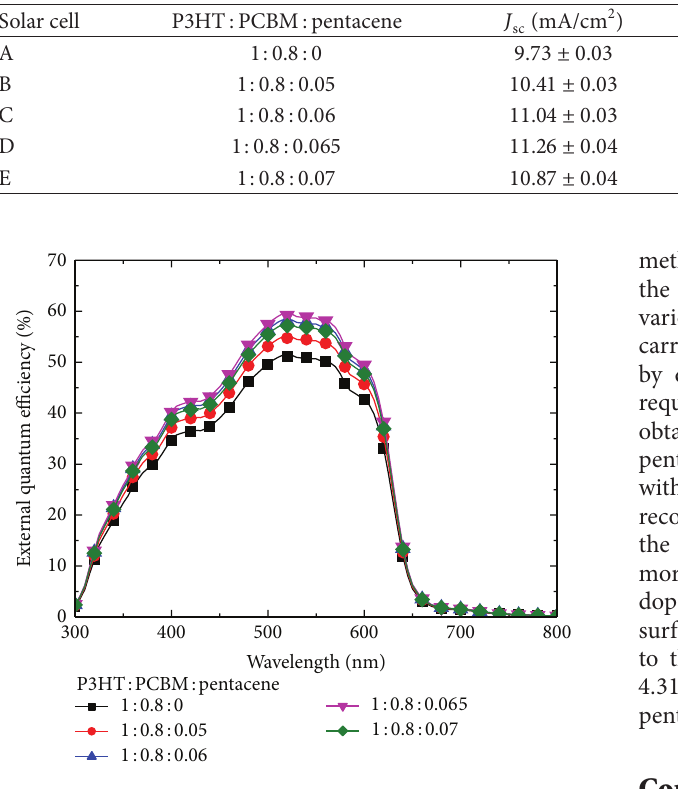
Figure 11: External quantum efficiency spectra of the inverted PSCs (solar cells A, B, C, D, and